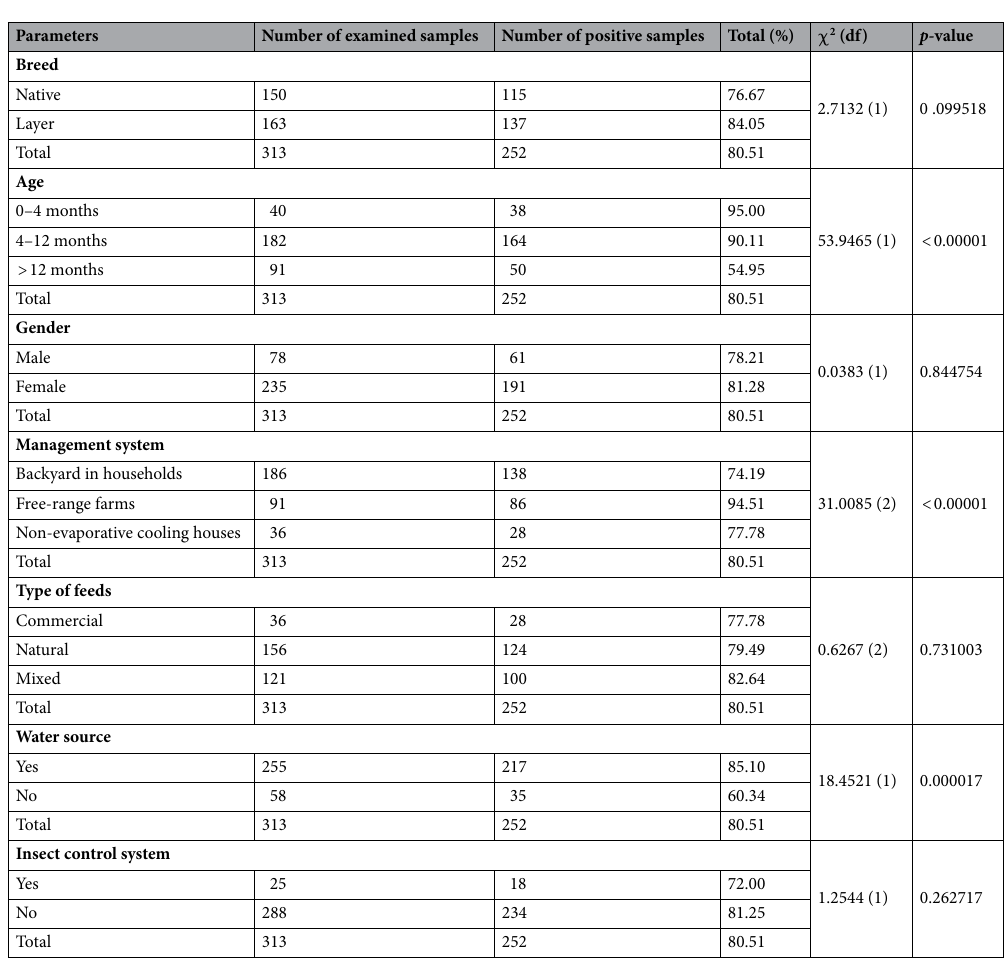
Table 2. Factors associated with L. sabrazesi infection of chickens in Chiang Rai, Kanchanaburi and Phatthalung provinces. χ 2 = Chi-square; df = degree of